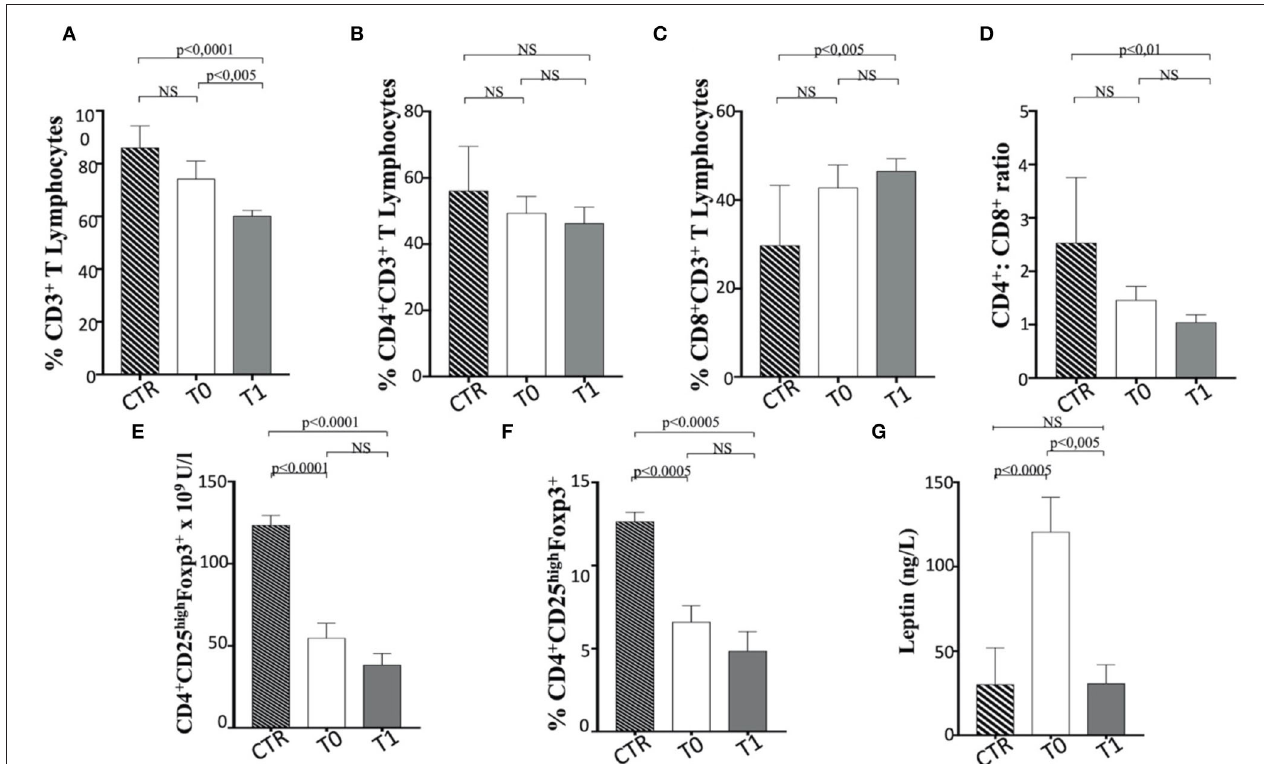
FIGURE 8 | The asset of T cell subsets and the serum level of leptin in enrolled dogs. (A–C) Percentage of total CD3 + , CD4 + , and CD8 + T lymphocytes in obese dogs, at T0 and T1, and control (CTR) subjects. (D) CD4 + CD8 + ratio. (E,F) Number (as n × 10 9 U/L) and percentage of Treg cells (indicated as CD4 + CD25 high FoxP3 + T cells), in obese, at T0 and T1, and CTR subjects. Referred values indicate results obtained in CTR group (dashed column), in obese dogs at T0 (white column) and T1 (gray column), as indicated. (G) Serum leptin level in obese dogs, at T0 (white column) and T1 (gray column), and CTR (dashed column) subjects. Statistics: Wilcoxon matched-pairs signed-rank test was used for T0 and T1 comparation in obese dogs, while Mann-Whitney test was performed for the comparation between T0 obese and CTR subjects. NS means not significant difference.